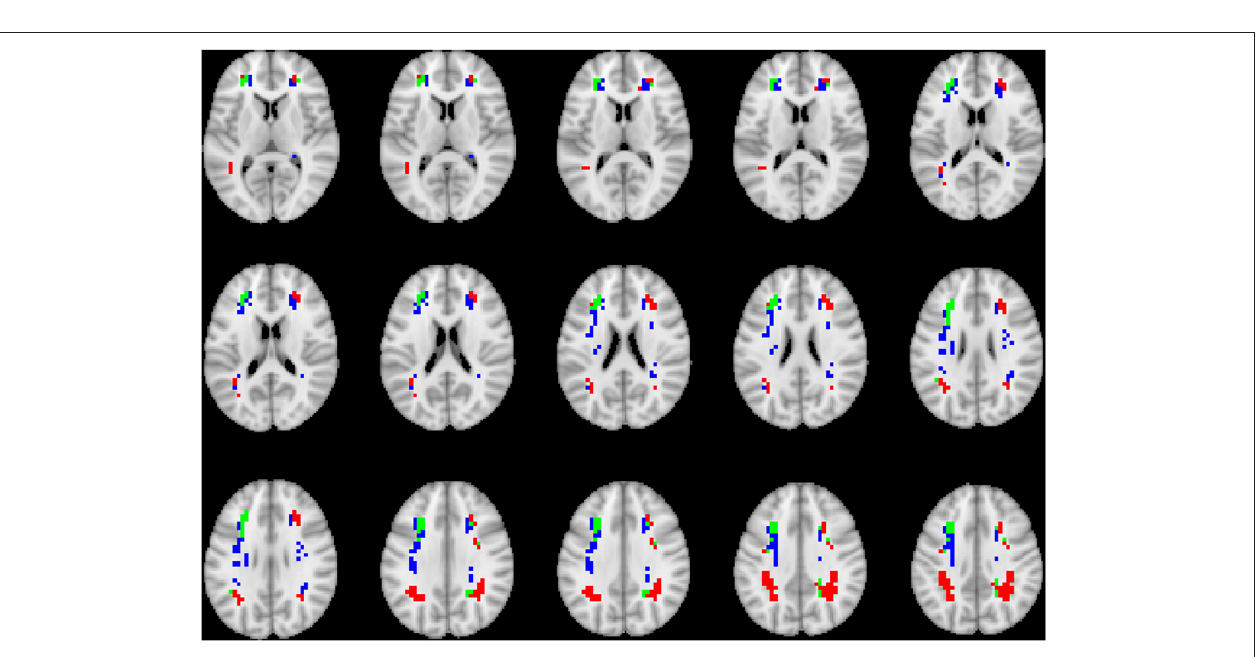
FIGURE 5 | Axial views of voxels primarily contributing to children classification in sMRI image. Green, common to DBD and TD groups; red, DBD group; blue, TD group. The right side of each image corresponds with the right side of the